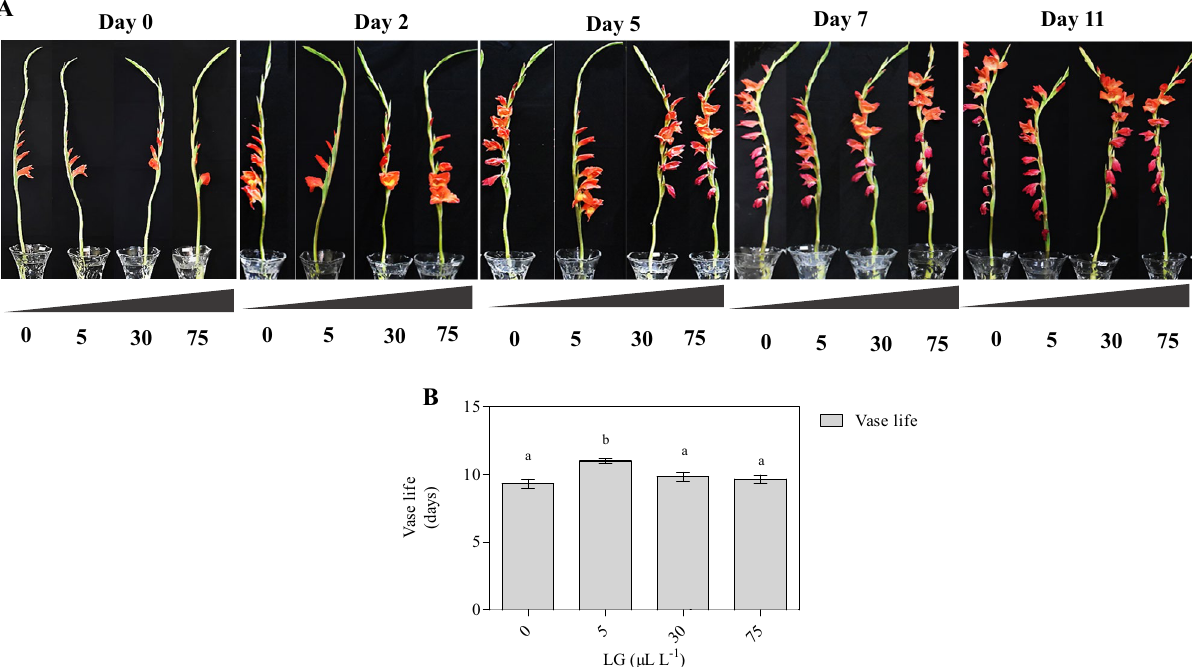
Figure 2. Representative photographs of vase performance ( A ), vase life ( B ) of gladiolus in untreated (control) and LG essential oil treated spikes. The Gladiolus grandiflorus spikes were treated with different LG oil concentration (0, 5, 30 and 75 µL L −1 ). Each value is the mean ± SE of three replicates. Means with different letters are significantly different at 5% probability (Tukey’s